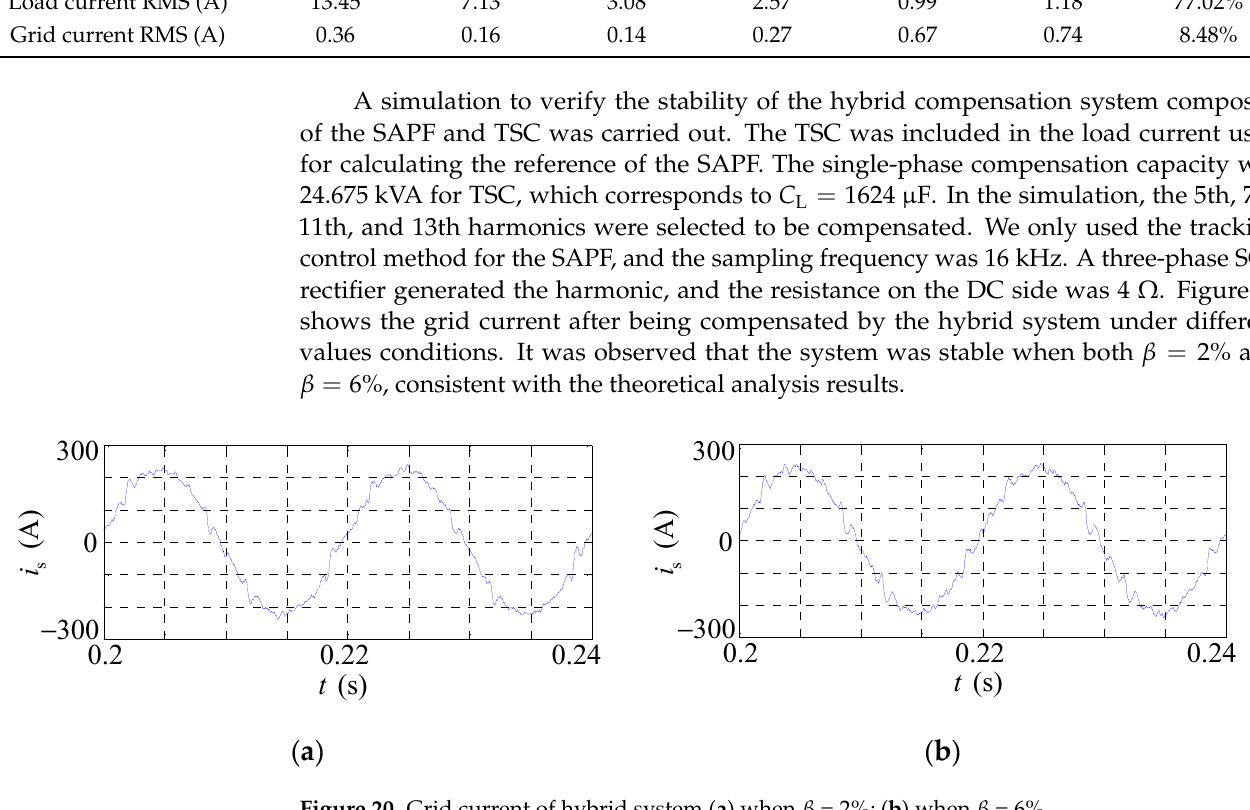
Table 3. Performance of shunt virtual damping control.